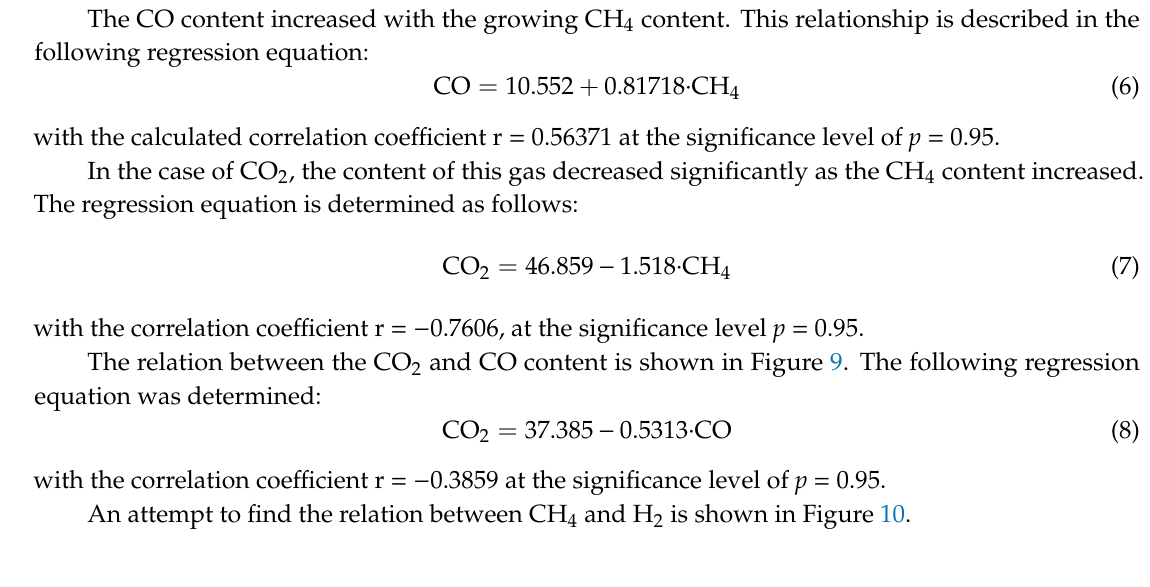
Figure 8. Correlation between percentage content of CO 2 and percentage content of CH 4 .